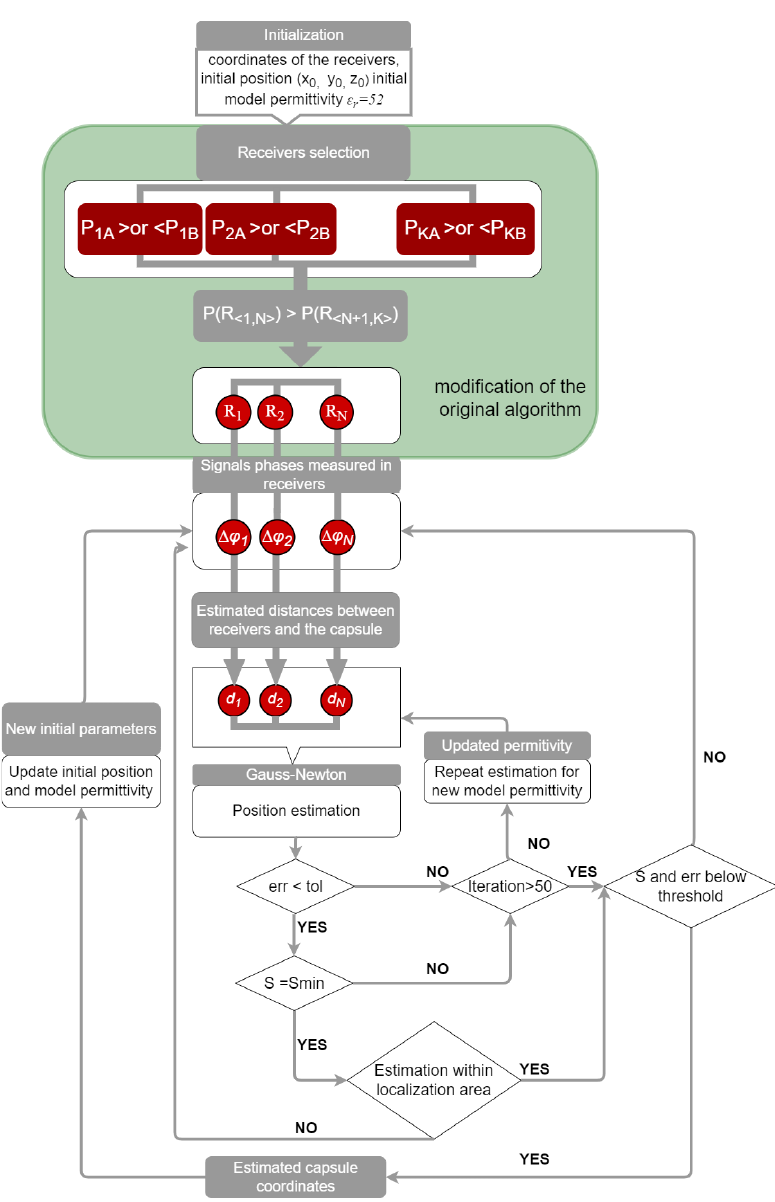
Figure 8. Improved localization algorithm with automatic selection of external receivers.